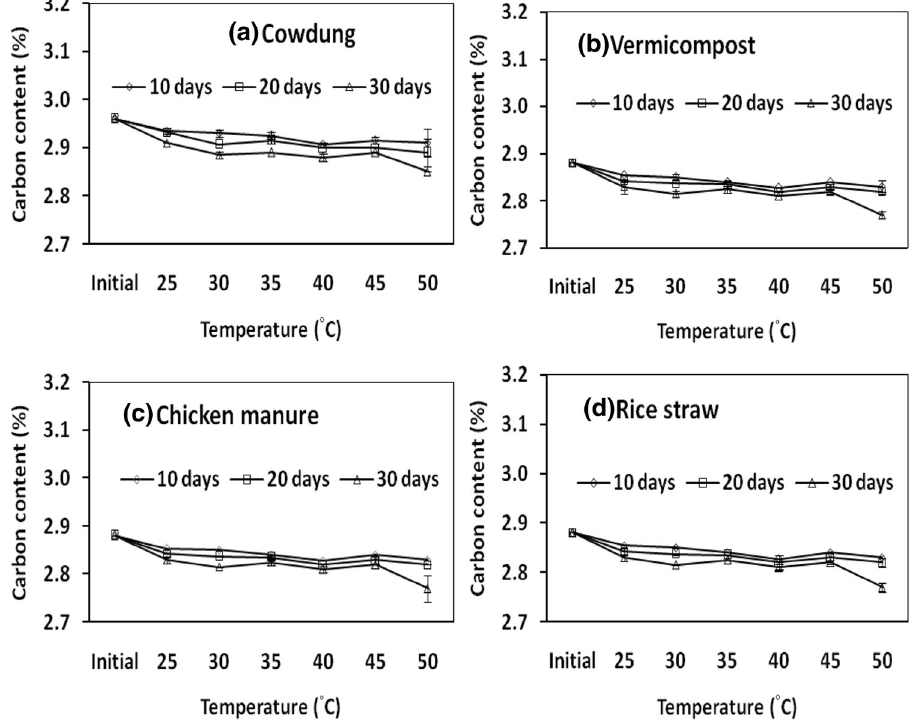
Fig. 2 Carbon reduction trends in different organic materials added soil: a cow dung, b vermicompost, c chicken manure, and d rice straw with temperature regimes and incubation